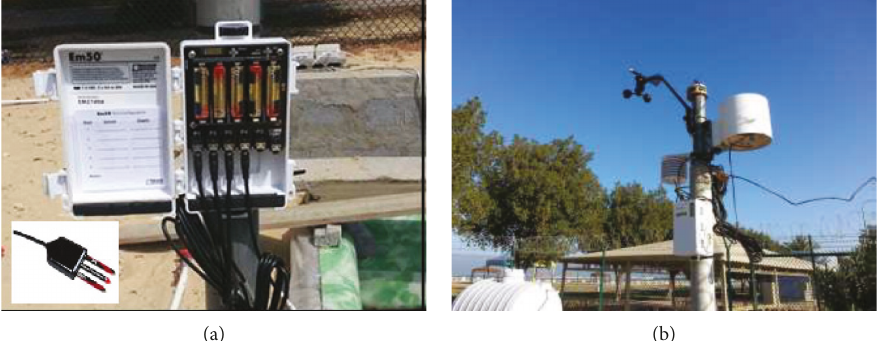
Figure 4: (a) Em50 data logger for 5TE sensors and (b) a weather station constructed on